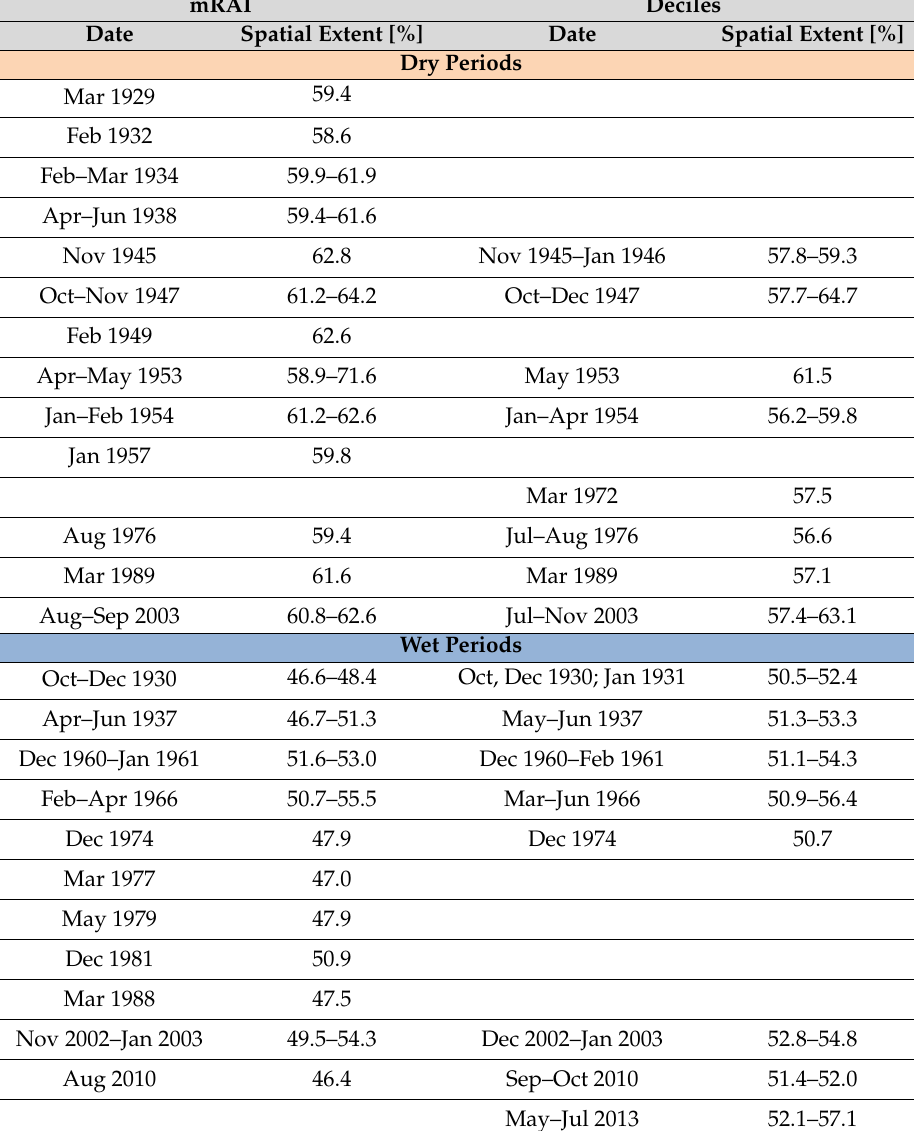
Table 3. Overview over the 20 months with the highest spatial extent of dry and wet periods over Europe, comparing the mRAI and the deciles index for period 1924–2015. The dates are given in chronological order with months belonging to the same period printed in the same line. The list may contain more than 20 months in case the same percentage value occurs several times.